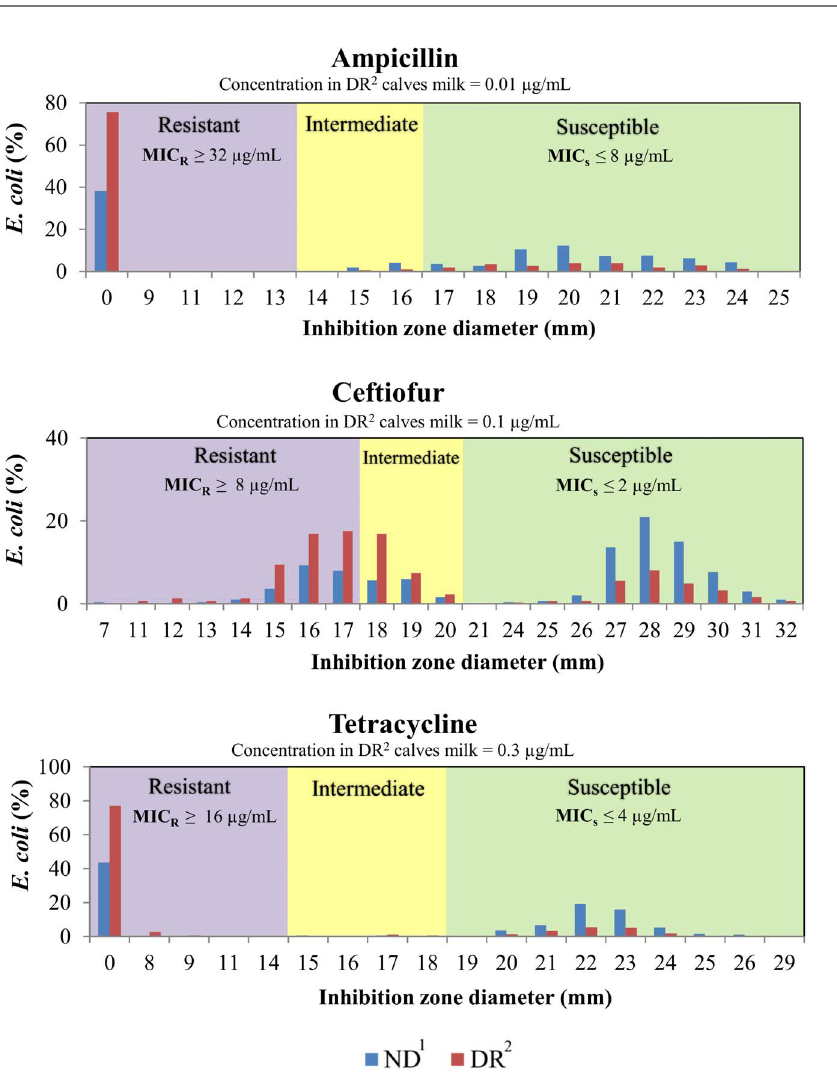
Fig. 1. Zone diameter histogram of all E. coli cultured from fecal samples and tested for antimicrobial susceptibility (n 5 609) to drugs added to the milk fed to DR calves. Data is stratified by milk feeding treatment group. Labeled shaded areas on graphs correspond to the zone diameter SIR classification according to Clinical and Laboratory Standards Institute (CLSI) breakpoints. The CLSI minimum inhibitory concentration breakpoints for E. coli classified as susceptible (MIC s ) and resistant (MIC R ) are displayed in graphs. 1. Calves fed raw milk without the addition of sub-MICs of antimicrobial drugs. 2. Calves fed raw milk with the addition of sub-MICs of ceftiofur, penicillin, ampicillin, and oxytetracycline from birth to 6 weeks of age.